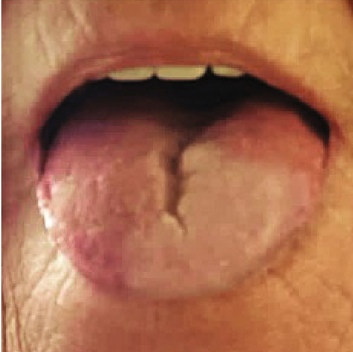
Figure 2: Picture of the oral tongue demonstrating left-sided tongue